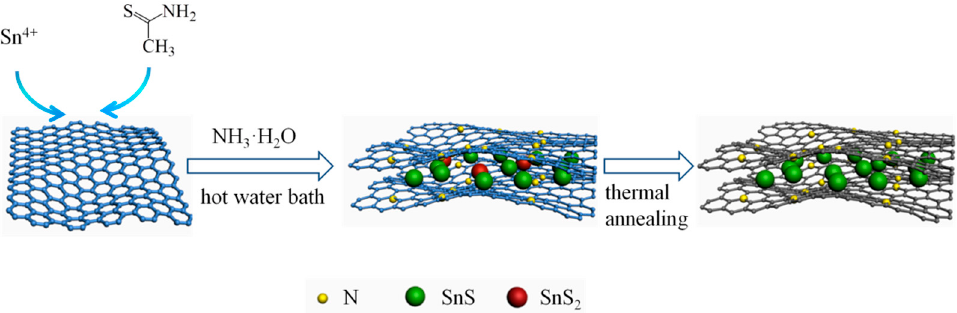
Figure 1. Schematic of synthesis of SnS/N-doped graphene (NG).